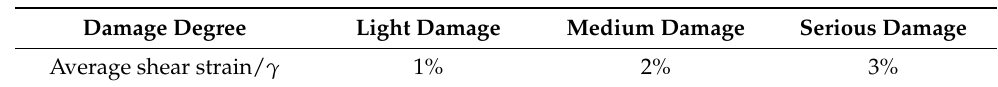
Table 5. Shear damage